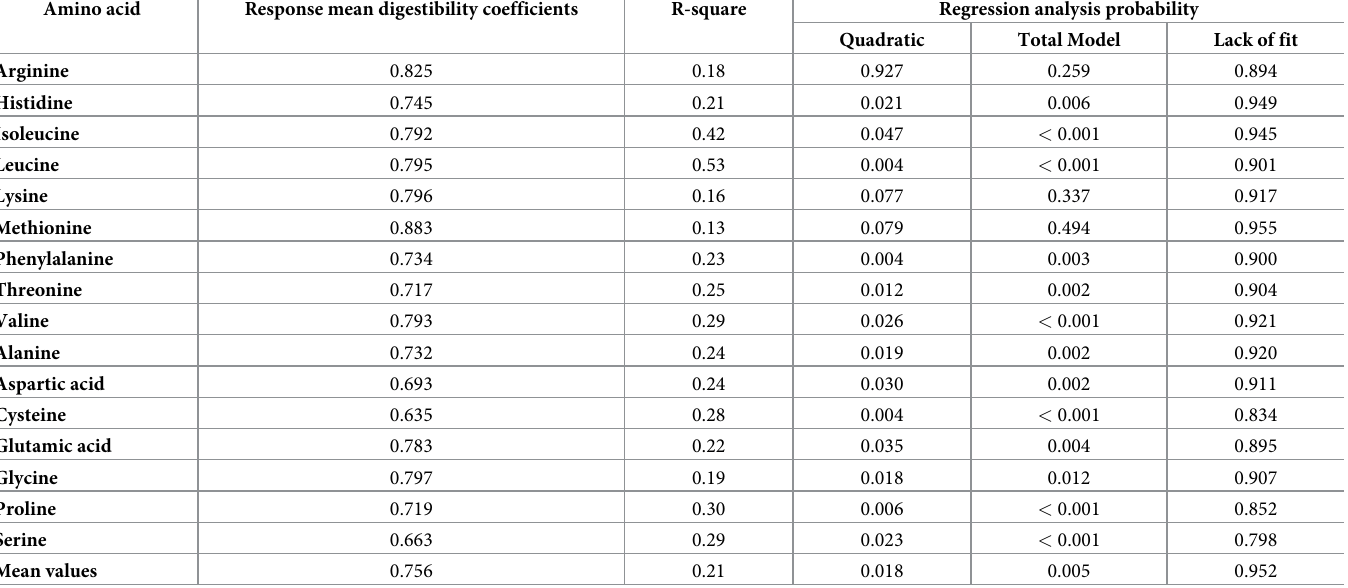
Table 12. Polynomial fitted model (P < 0.05) for apparent digestibility coefficients of amino acids at 28 days post-hatch. Amino